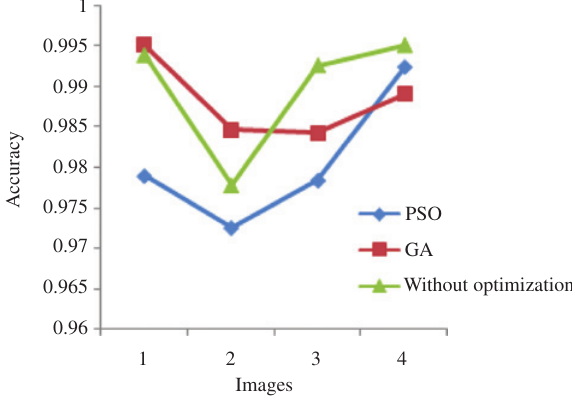
Figure 6: Accuracy Graph for Three Optimization Algorithms.